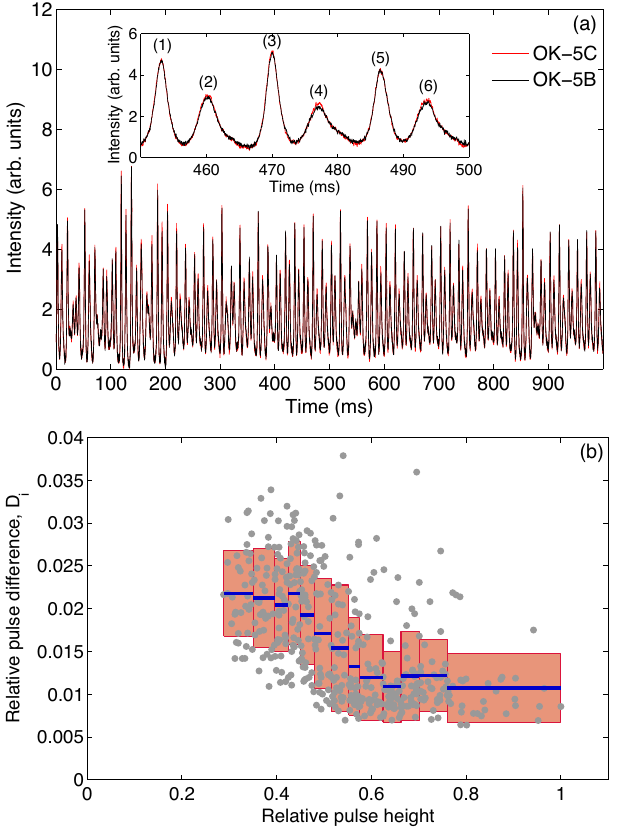
FIG. 5. FEL macropulses of the two orthogonal circular polarization components decomposed from an FEL beam with good average horizontal polarization. (a) FEL intensity measured in the time domain over one second. The inset is an enlarged plot, showing six consecutive FEL macropulses. (b) Relationship between the pulse difference D i and the pulse height for 455 macropulses collected from four one-second measurements (gray dots). The pulse height is normalized in a way to equalize the average intensity of the two macropulse signals. The data sorted into 13 bins using the pulse height are analyzed to show the averaged pulse difference (blue lines) and rms spread (red rectangles). For this measurement, the electron beam energy is 533 MeV and beam current is 33 mA in the single bunch. The FEL is operated at 544 nm with close to zero FEL